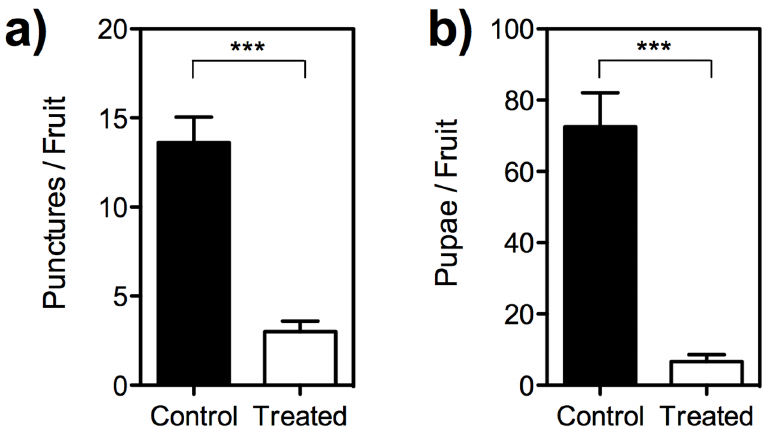
Fig 3. The response of female B . dorsalis to the SA treated fruit from the field. (a) Ovipunctures (b) the number of pupae emerged per fruit. The field experiment data shows that the number of punctures and pupae was decreased in the SA treated when compared to the control fruit (paired t test, t = 8.12, df = 7, P = 0.0001 [ovipunctures], t = 6.46, df = 7, P = 0.0003 [pupae]). Error bars = Standard error of